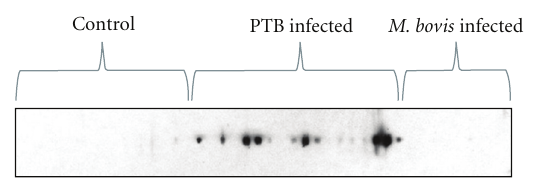
Figure 2: Evaluation of the cocktail by a Line print immunoassay. Result of the cocktail with seven antigens (MAP 0038, MAP 0210c, MAP 1272, MAP 1693, MAP 2020, MAP 0209c and MAP 2513) printed in a membrane of nitrocellulose and evaluated with the sera from healthy animals and animals infected with MAP and M. bovis